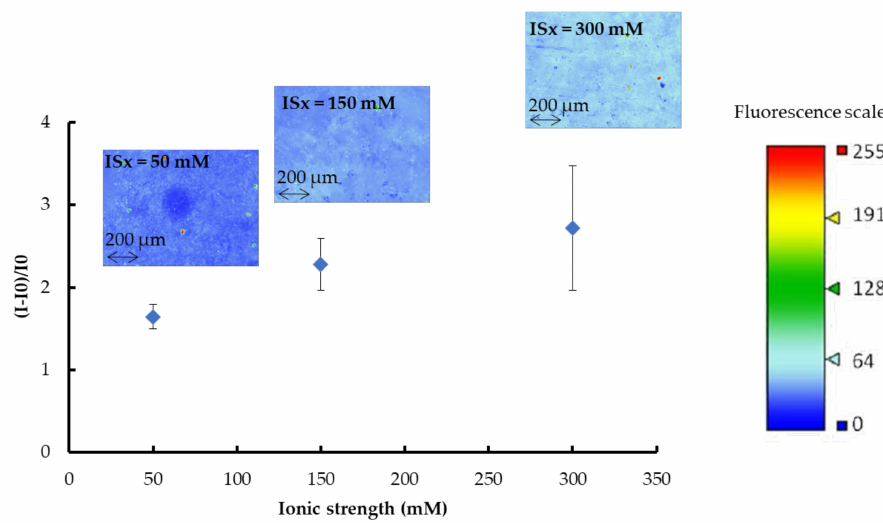
Figure 6. Relative fluorescent gains and fluorescence images (recorded as false color) of gold (AuNPs-1)-coated OSTE plates functionalized with fluorescent thiolated aptamer in sodium phosphate bu ff er (pH 8, ISx with x = 50, 150, and 300 mM) + 5 mM MgCl 2 . I0 is the fluorescence intensity of the gold-coated OSTE substrate. I is the fluorescence intensity measured after functionalization with fluorescent thiolated aptamers and rinsing (See experimental section for more details on experimental conditions and fluorescence measurement parameters). The error bars represent the standard deviation for three